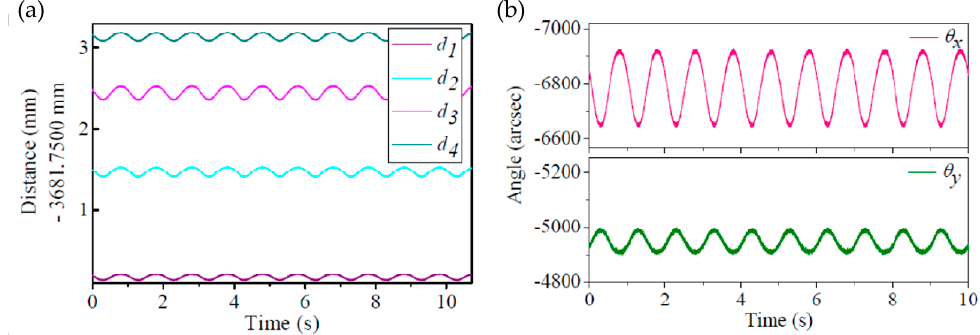
Figure 14. Dynamic measurement of the absolute angular position of an object by a dual-comb based absolute distance measurement method [63]: ( a ) Measured absolute distances of the four measurement points; ( b ) Variations of the absolute angular positions calculated from the measured absolute distances.